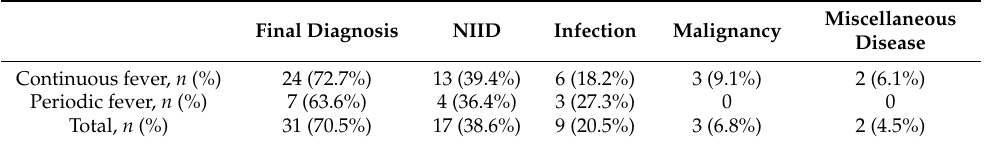
Table 2. Diagnostic groups in patients with a final diagnosis among the study FUO population ( n = 44).